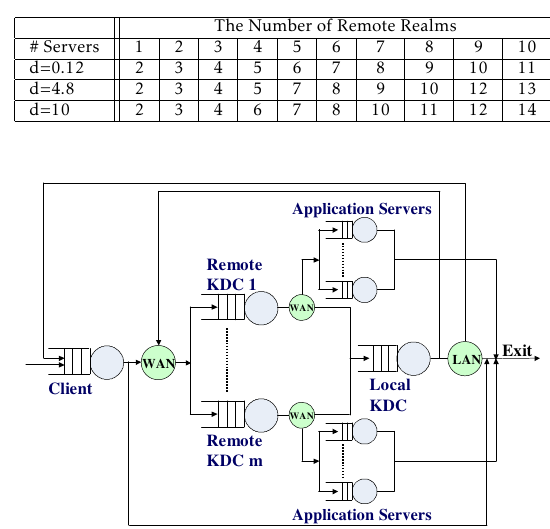
Table 7. The Minimal Number of Application Servers